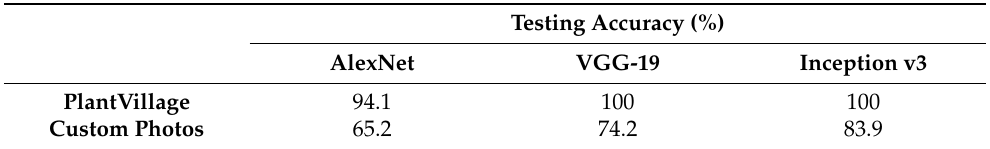
photo dataset for the fine-tuning approach.